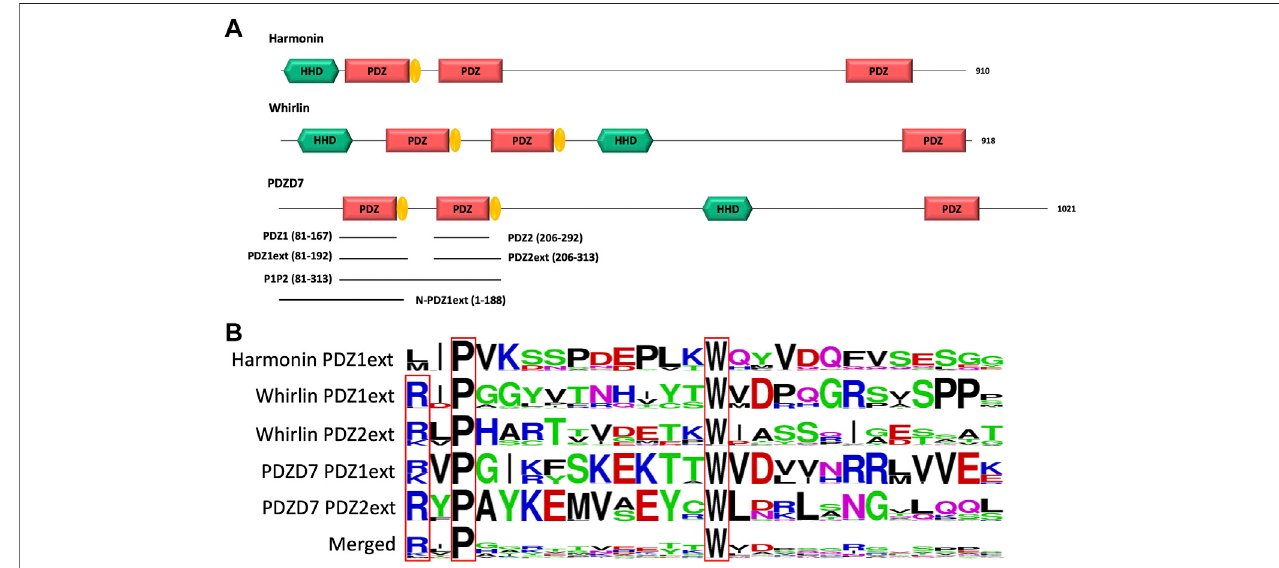
FIGURE 1 | (A) Schematic representation of the modular organization of the three paralogous proteins harmonin, whirlin and PDZD7. PDZ domain extensions are indicated in yellow. The 6 constructs of PDZD7 used in our in vitro study are indicated by black lines aligned to the corresponding fragment of PDZD7. Indicated delimitations correspond tothemouse protein sequence. (B) Comparison ofPDZ domain extension sequencesfrom harmonin, whirlin and PDZD7.Foreach extension, allUniprotKBsequences ofthecorrespondingproteinwerealigned.Theresultisdisplayed usingalogorepresentation,wheretheheightofeachresidueone-letter code translates to its conservation at the corresponding position in the sequence alignment (Crooks et al.,